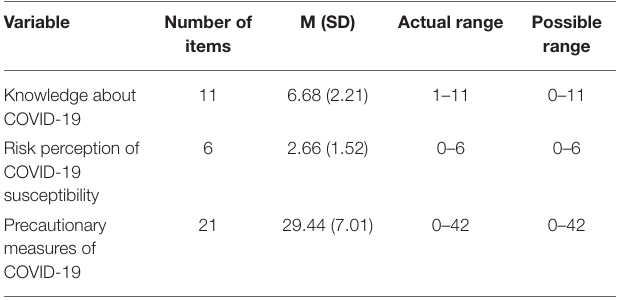
TABLE 2 | The levels of knowledge, risk perception, and precautionary measures of COVID-19 among medical students.